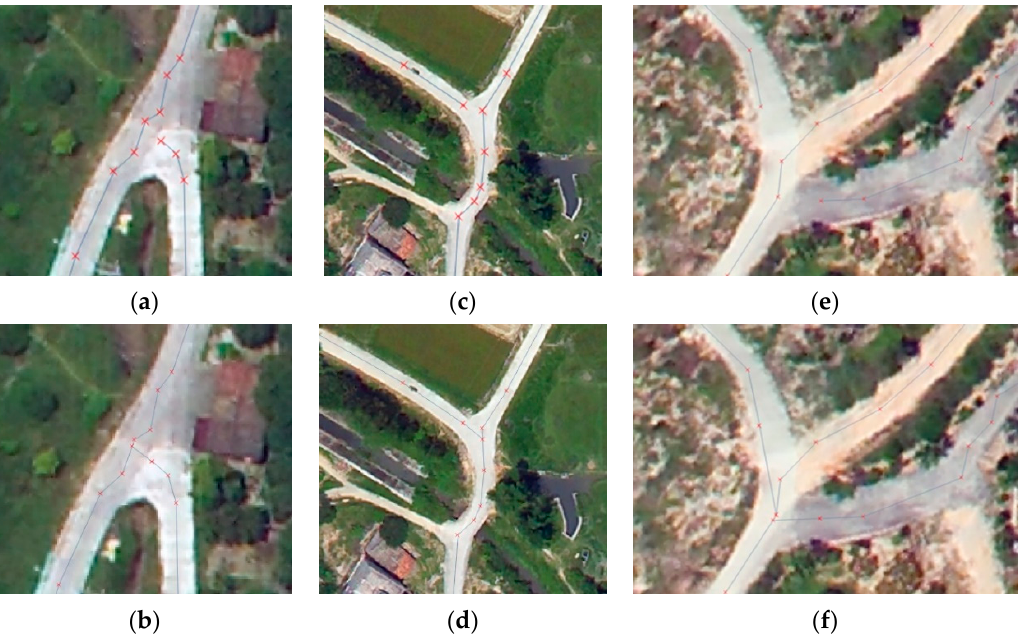
Figure 12. Description of road intersections: ( a ) ‘T’ ‐ or ‘Y’ ‐ shaped intersection; ( b ) simple situation of ‘+’ ‐ shaped intersection; ( c ) multiple situations of ‘+’ ‐ shaped intersections.